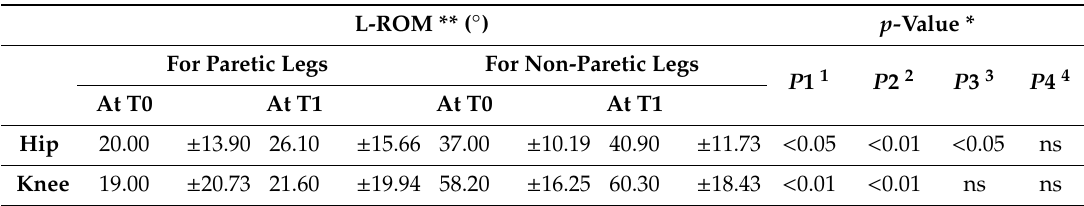
Table 4. Mean and standard deviation (SD) of the L-ROM (range of motion) measures ( ◦ ) for paretic and non-paretic limbs at basal assessments (T0) and one-month follow-up (T1).